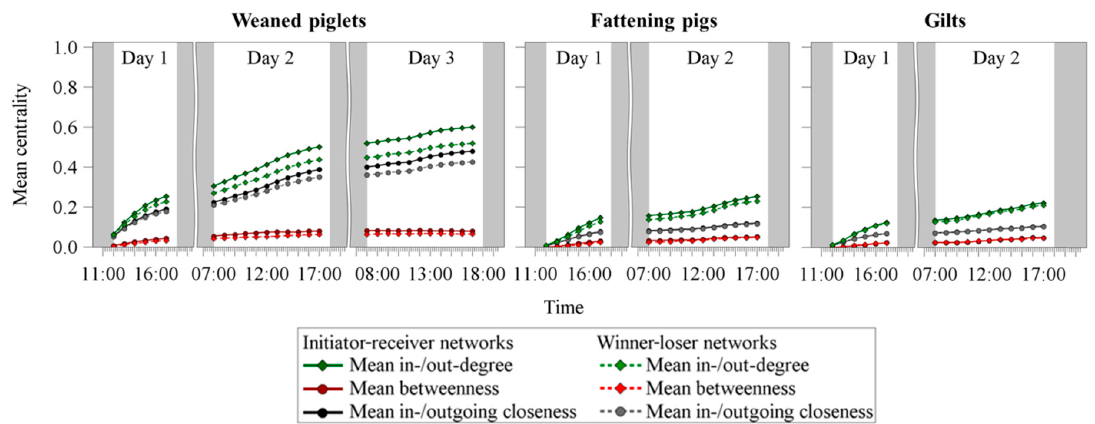
Figure 3. Temporal development of the mean centrality parameters for the initiator-receiver networks and the winner-loser networks for the age groups: weaned piglets, fattening pigs and gilts. For illustration purposes, the figure illustrates the standardized in- or out-degree centrality ranging from 0 to 1 in order to enhance the comparability to the other centrality